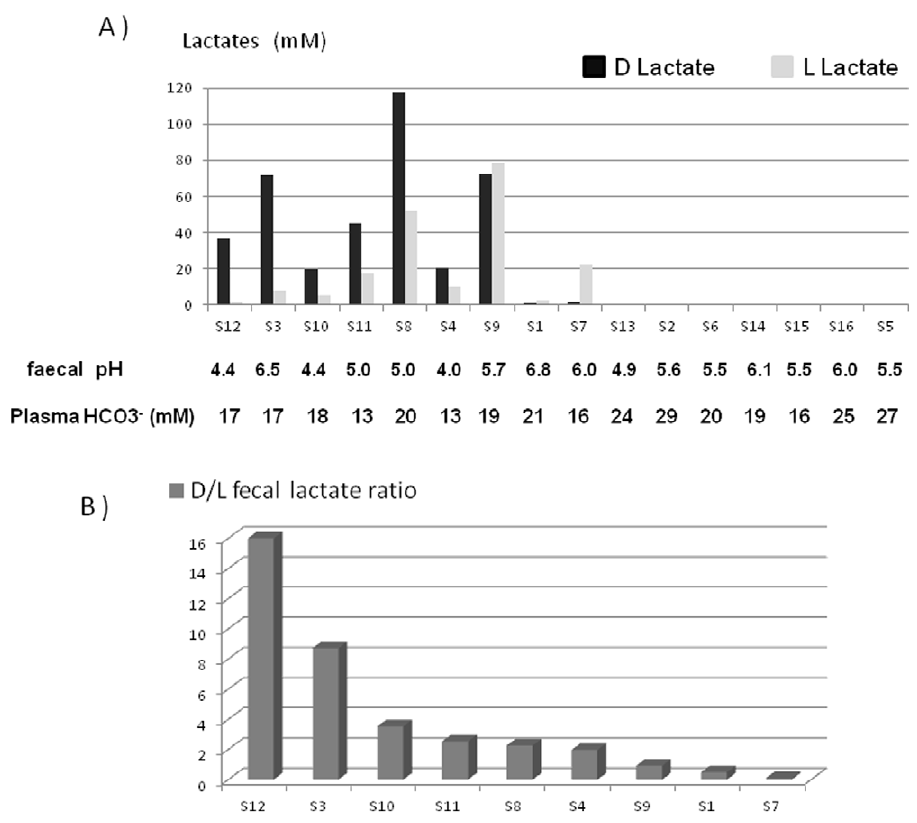
Figure 2. D and L-Lactates in faeces of SBS patients. A- Concentration of D and L lactate (mM) in SBS faeces revealed two groups : the faecal lactate-accumulator group (LA) and the non-accumulator group (NLA,). Individual faecal pH and plasma HCO3 – concentration (mM) was indicated. B- Faecal D/L lactate ratio in the SBS LA group of SBS patients. doi:10.1371/journal.pone.0054335.g002 correlation 2 0.50, p = 0.04 and 2 0.53, p =0.03). We did not find